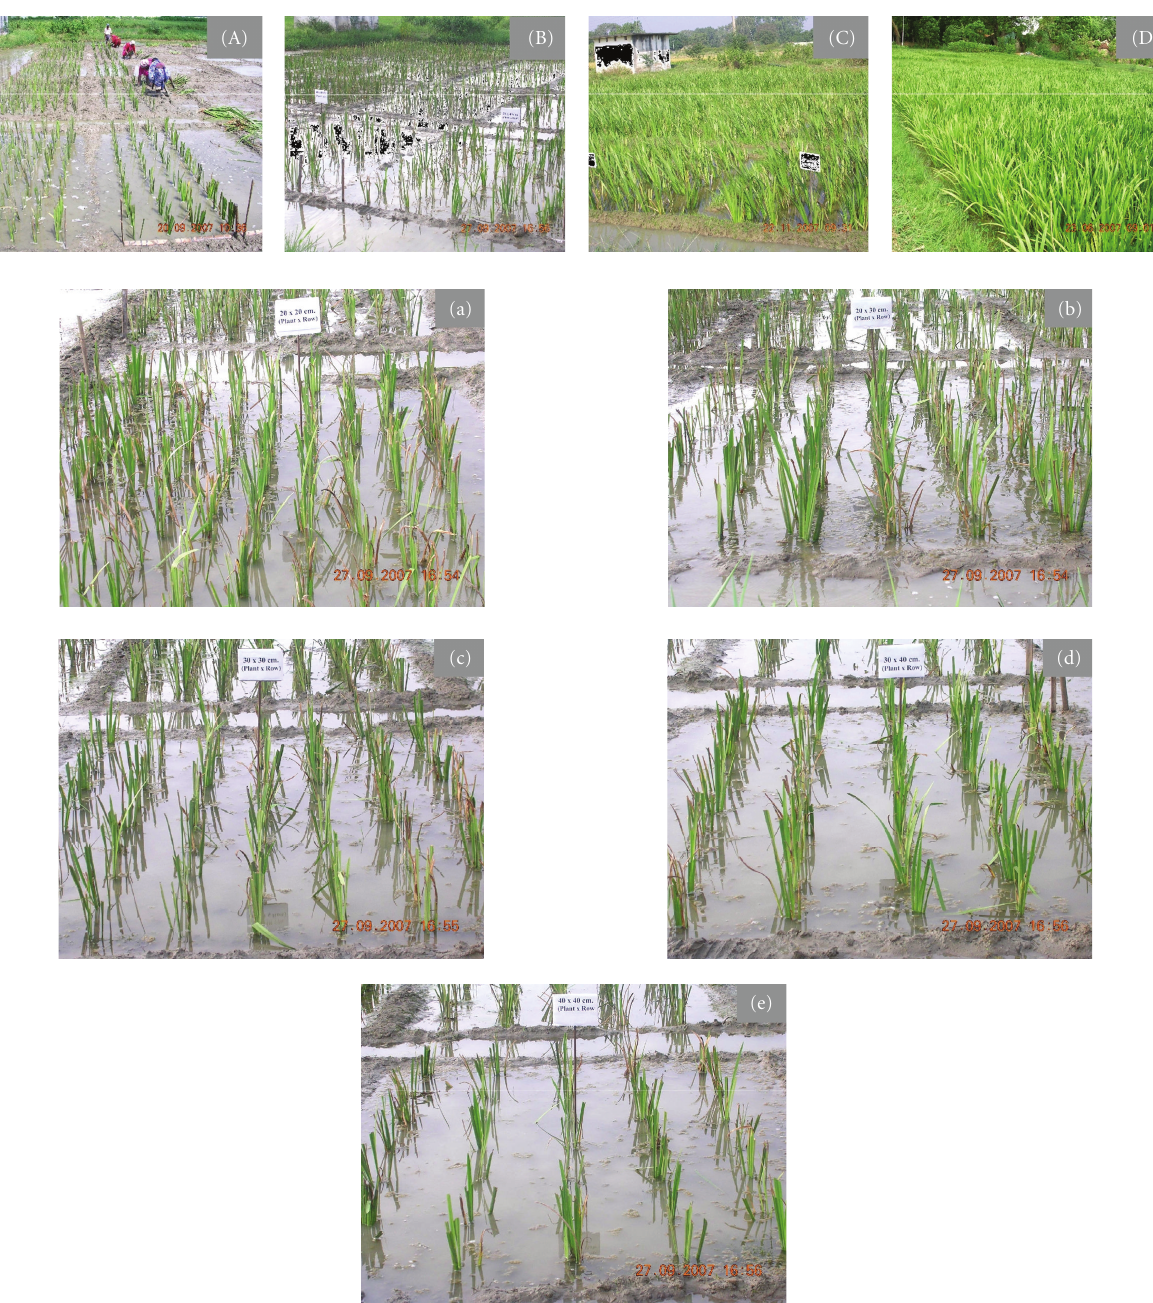
Figure 3: View of experimental plot ((A) at planting; (B) after 3 months; (C) after 6 months; (D) after 12 months) and di ff erent spacing treatments ((a) 20 × 20 cm; (b) 20 × 30 cm; (c) 30 × 30 cm; (d) 30 × 40cm; (e) 40 ×